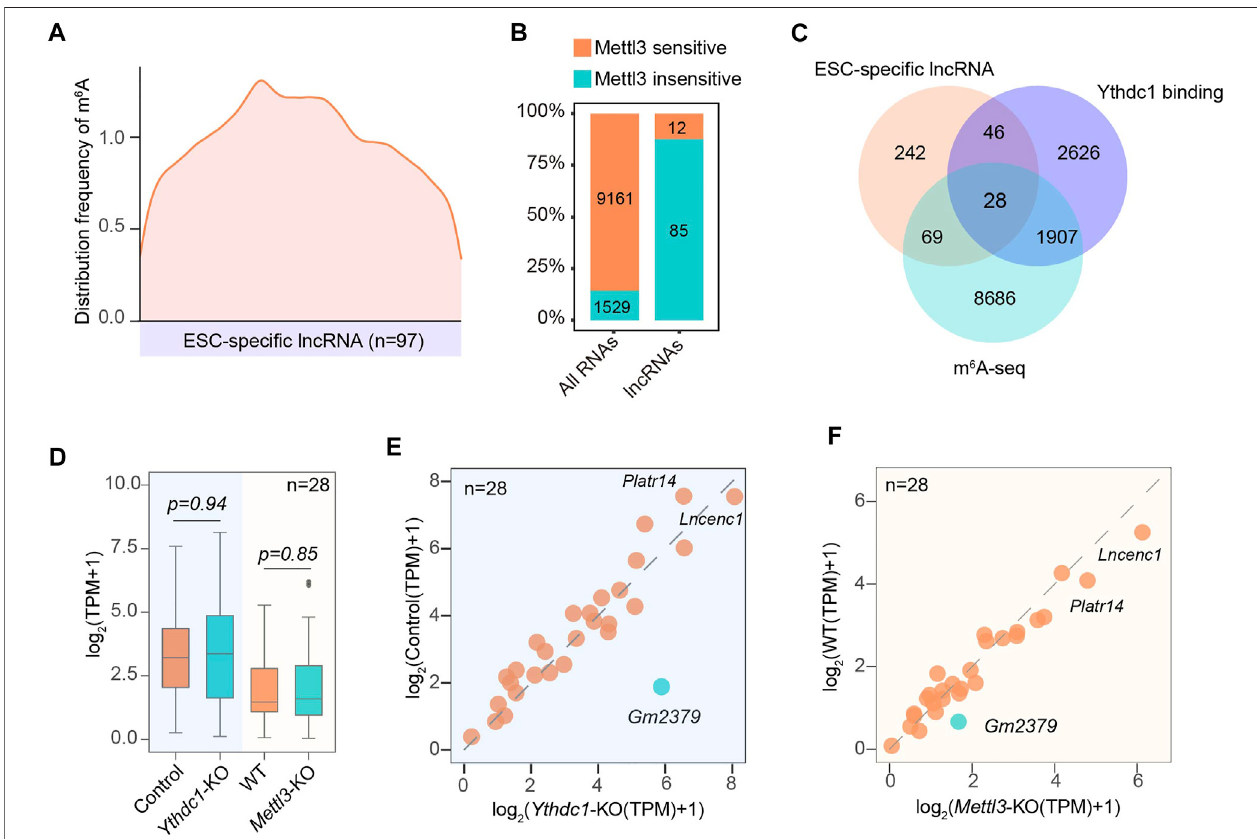
FIGURE 4 | Characterization of the modi fi cation status on ESC-speci fi c lncRNAs by m 6 A. (A) Transcriptome-wide distribution pattern of m 6 A for ESC-speci fi c m 6 A-containing lncRNAs. (B) The percentage and number of ESC-speci fi c lncRNAs containing m 6 A peaks that are regulated by Mettl3. (C) A Venn diagram shows the overlapping of lncRNA transcripts containing m 6 A sites and binding with nuclear m 6 A “ reader ” Ythdc1. (D) A box plot shows the expression of 28 overlapped lncRNAs (C) containing m 6 A sites and binding with Ythdc1 in response to the depletion of Mettl3 or Ythdc1. (E) A scatter plot showing the expression changes of 28 overlapped lncRNAs (C) in the presence or absence of Ythdc1. (F) A scatter plot showing the expression changes of 28 overlapped lncRNAs (C) in the presence or absence of Mettl3. Gm2379 is highlighted in green.